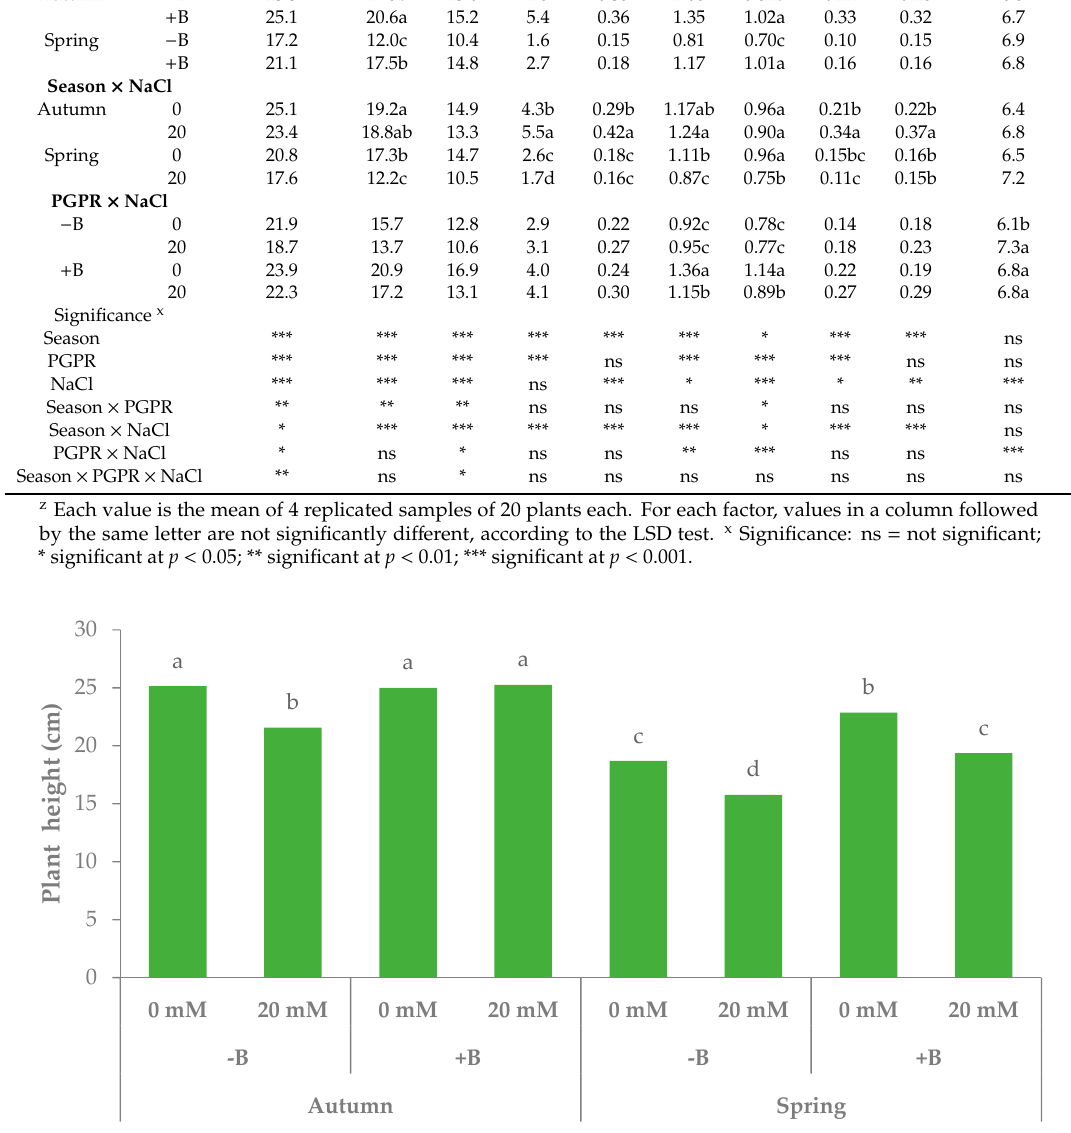
Figure 3. Height of leaf lettuce plants grown during autumn and spring in nutrient solutions containing different levels of NaCl (0 mM and 20 mM) and with (+B) or without (-B) bacterial biostimulant (bars with different letters are significantly different at p < 0.05, according to the LSD test). Table 1. Morphological parameters of leaf lettuce plants grown during autumn and spring in nutrient solutions containing different levels of NaCl and bacterial biostimulant.